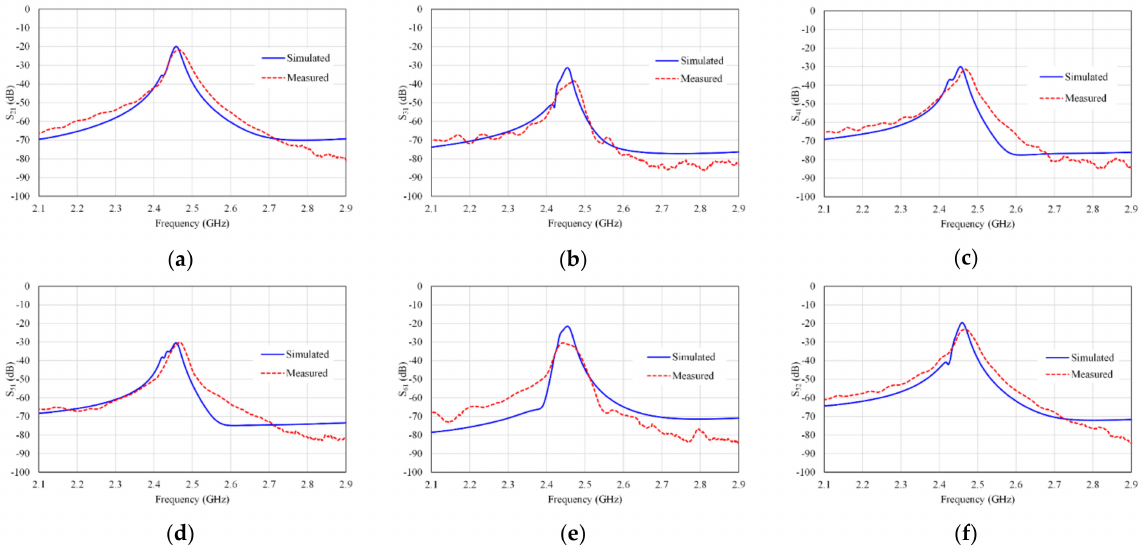
Figure 10. Simulated and measured S parameters ( a ) S 21 , ( b ) S 31 , ( c ) S 41 , ( d ) S 51 , ( e ) S 61 , and ( f ) S 52 .